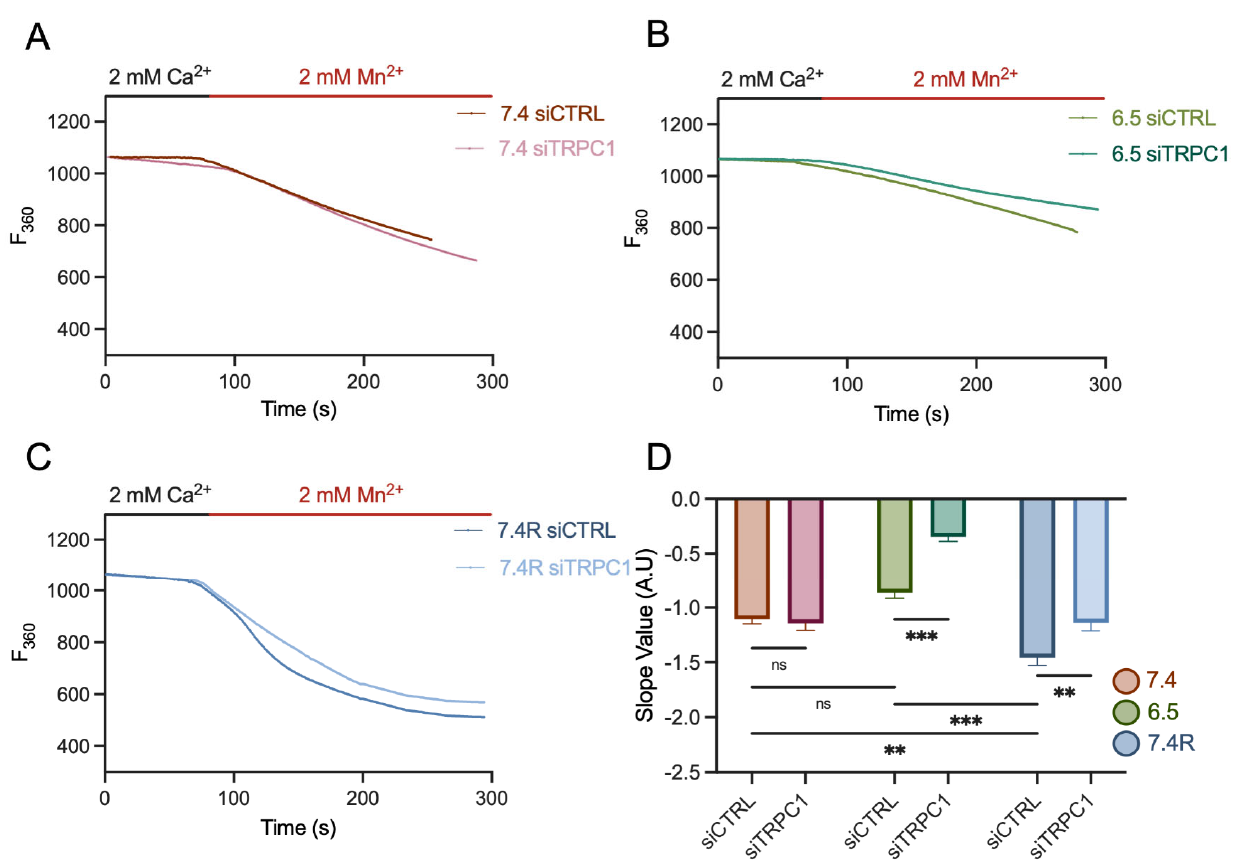
Figure 9. TRPC1 reduces basal Ca 2+ entry in acid adaptation and recovery conditions. ( A ) Representative traces of Mn 2+ quenching in transfected PANC ‐ 1 cells grown in normal pH conditions (7.4), ( B ) in acid adaptation (6.5) conditions, or ( C ) in acid recovery conditions (7.4R). ( D ) Quantification of siCTRL and siTRPC1 transfected PANC ‐ 1 cells in all three conditions (number of analyzed cells; pH 7.4 siCTRL n = 150 and siTRPC n = 128, pH 6.5 siCTRL n = 405 and siTRPC n = 326, pH 7.4R siCTRL n = 325 and siTRPC n = 214). Tukey’s multiple comparison test was used to determine significant differences between conditions. ns indicates non-significance. ** and *** indicate p < 0.01 and 0.001, respectively.